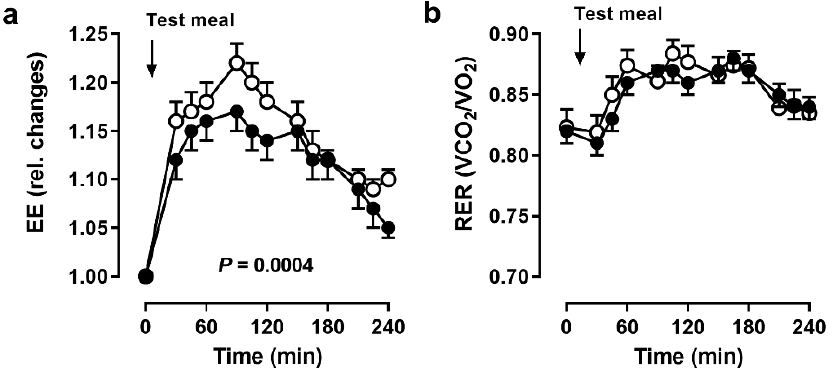
Figure 3. Systemic energy metabolism. ( a ) Energy expenditure (EE) and ( b ) respiratory exchange ratio (RER) before and after a meal in 11 men before (open circles) and during (closed circles) Bahá’í fasting. Data are presented as mean (SEM), p values by ANOVA.